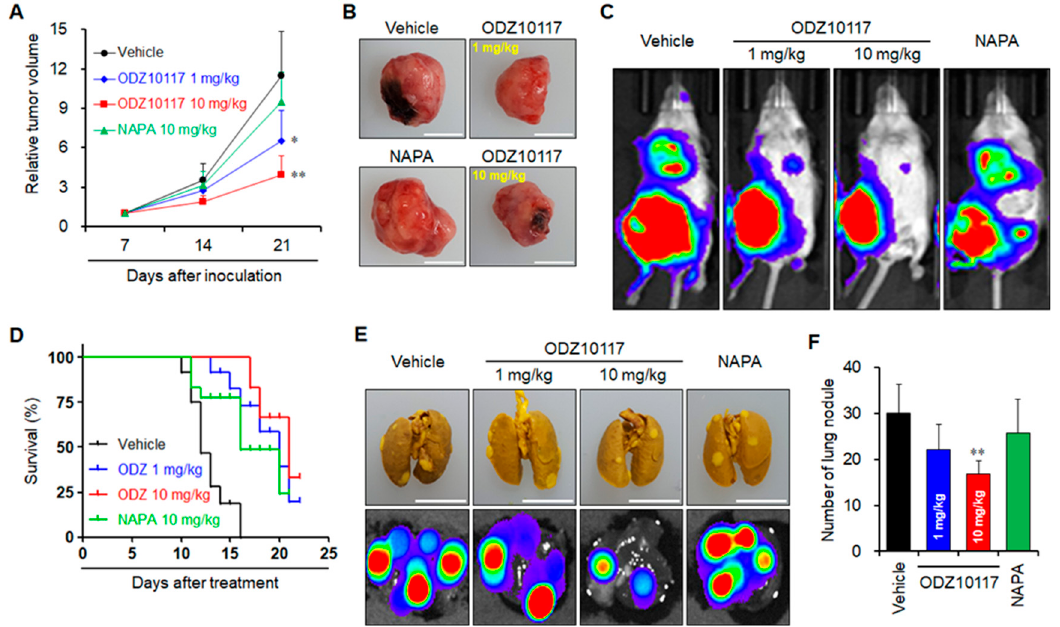
Figure 8. ODZ10117 inhibits tumor growth and lung metastasis and increases survival in breast cancer xenograft model. ( A – F ) Syngeneic breast metastasis xenograft model was generated by injection of 4T1-Luc cells into the right fourth mammary fat pad of female BALB/c mice. Primary tumor growth is shown ( A , B ). Representative bioluminescence images of whole body ( C ). Kaplan-Meier survival graph of tumor-bearing mice ( D ). Lung metastatic tumor nodules were observed on the surface (upper) and bioluminescence images (bottom) of the lung ( E ) and lung nodules were counted ( F ). * p < 0.05 and ** p < 0.005 compared to the vehicle-treated group.